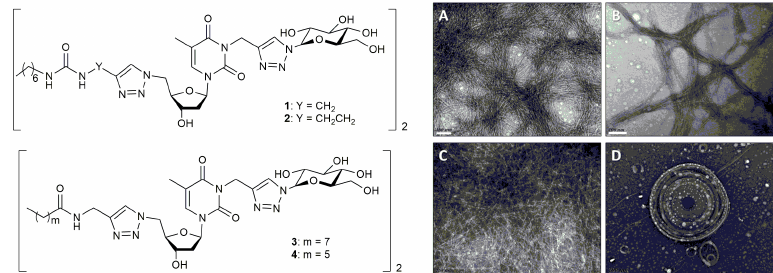
samples at 2% w/v obtained for bolaamphiphiles ( A ) 1 (scale bar: 100 nm), ( B ) 2 (scale bar: 100 nm), ( C ) 3 (scale bar: 100 nm) , and ( D ) 4 (scale bar: 200 nm). Image adapted with permission from reference